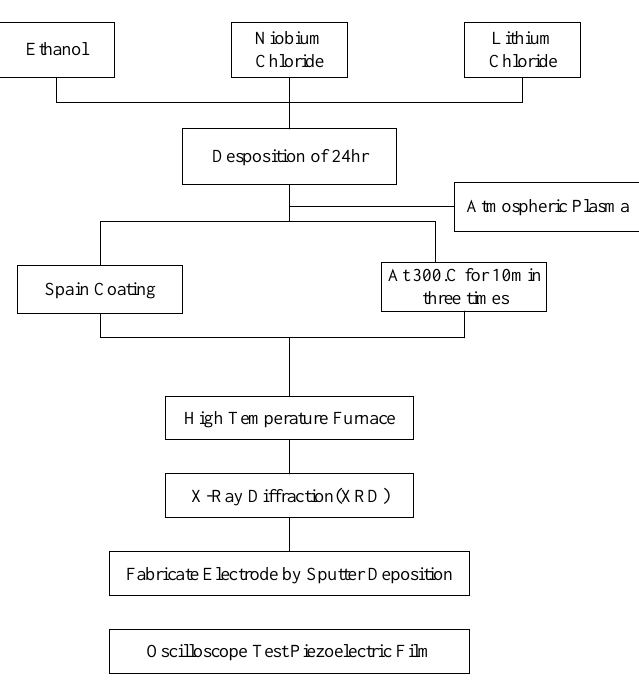
Figure 4. The flowchart of fabrication process.